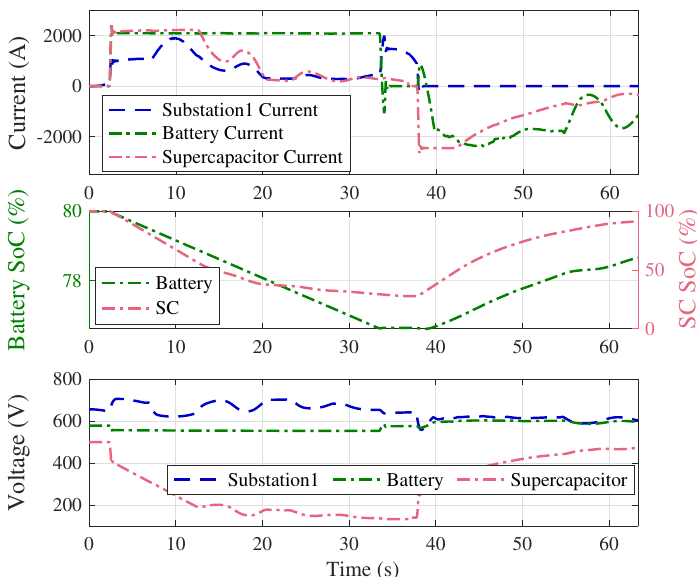
Figure 18. Substation1, Battery, and SC parameters for 45% energy saving with an HESS consisting of battery and